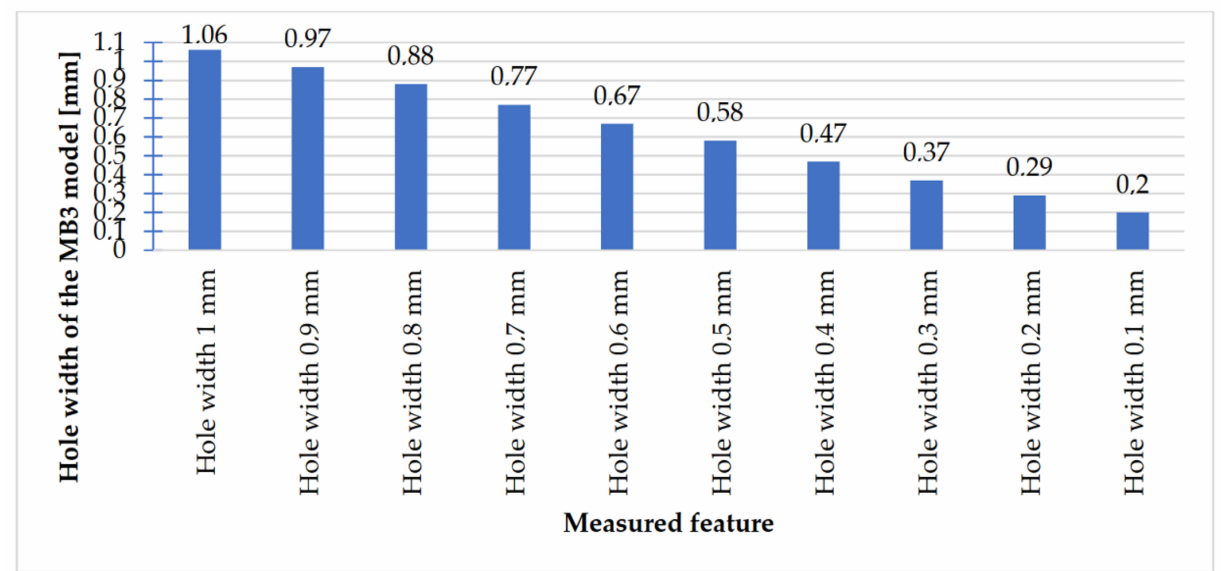
Figure 24. Measured values of rectangular holes in the range of 1–0.1 mm.